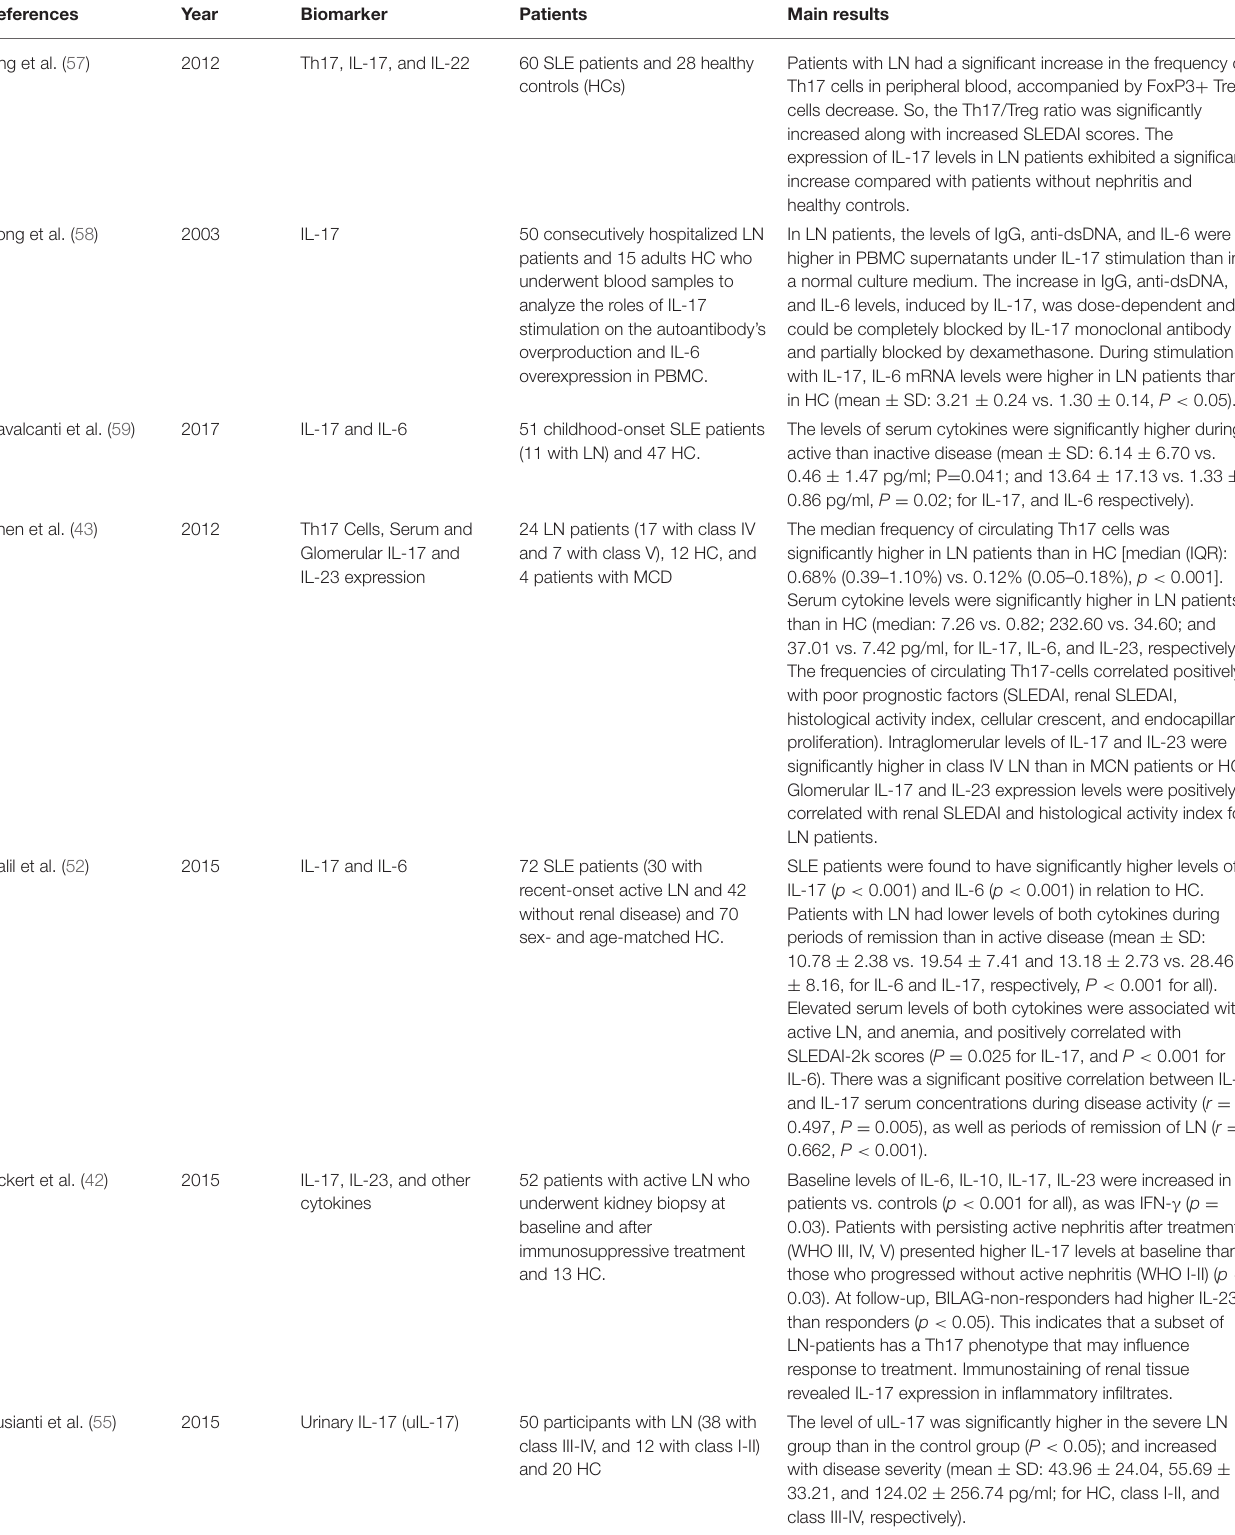
TABLE 1 | Clinical Studies on the role of the Th17/IL-17 axis and associated Imbalances in lupus